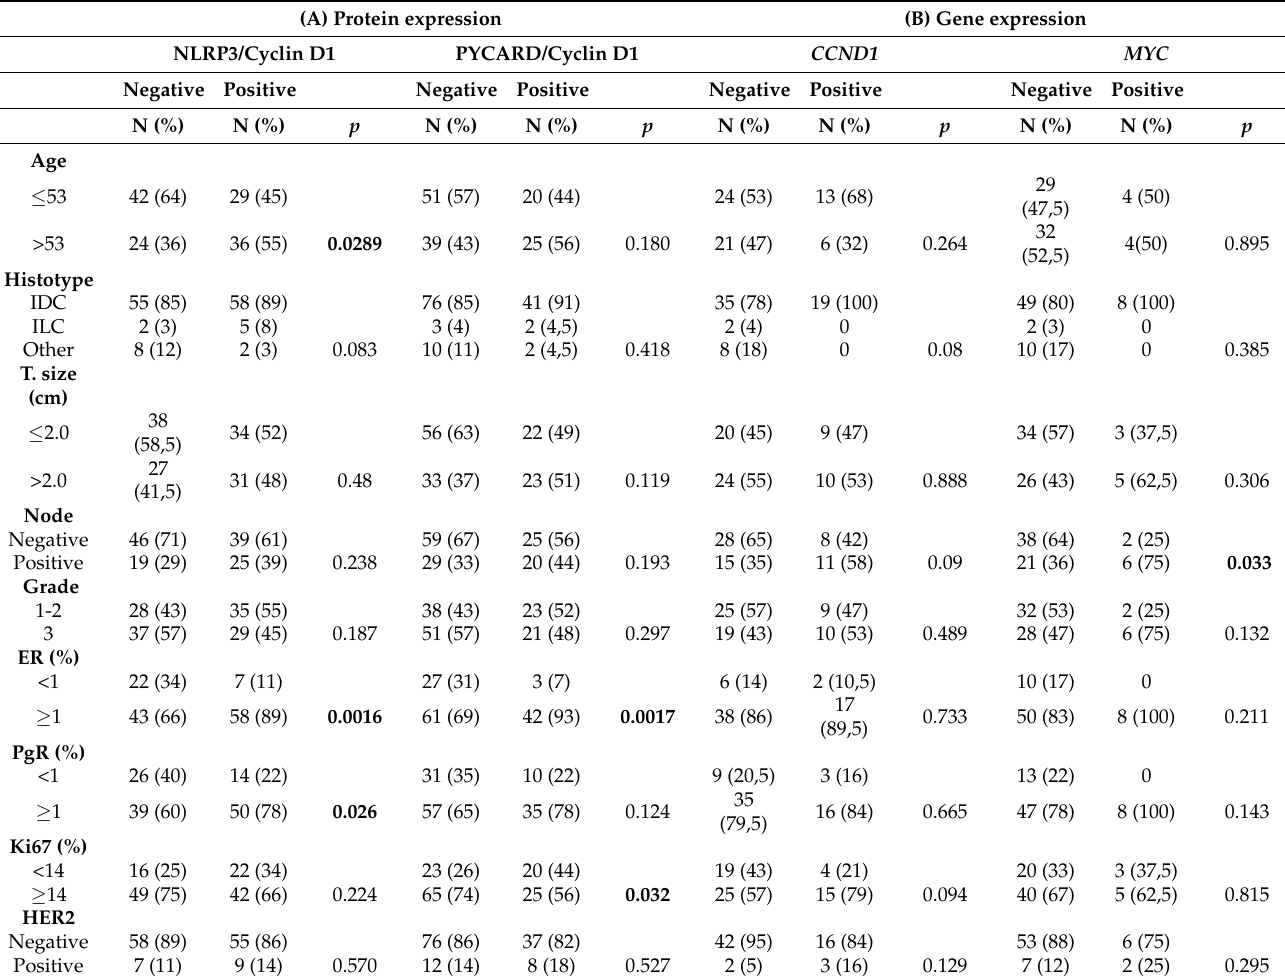
Table 4. Coupled biomarkers and clinicopathological